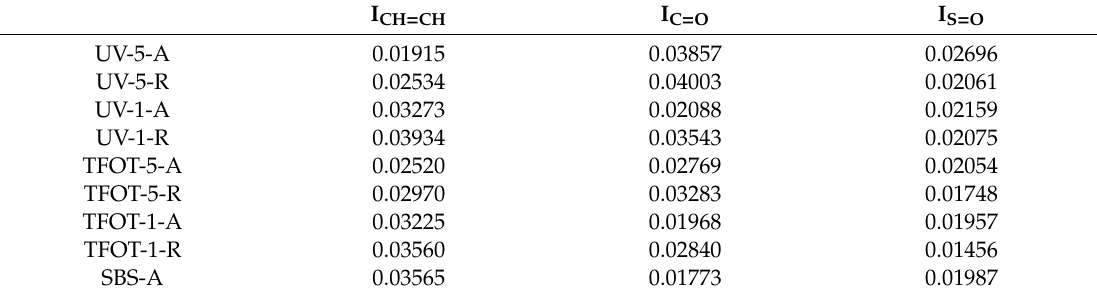
Table 7. Structural indices of